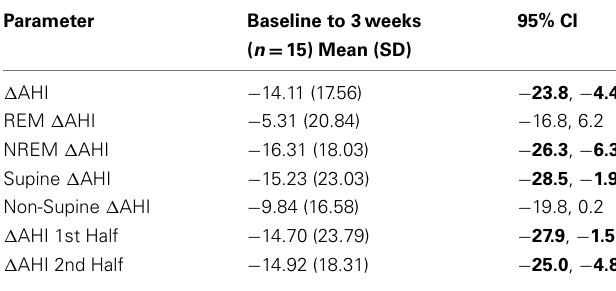
Table 2 | Primary and secondary efficacy outcomes: within-subjects change in apnea hypopnea indices with